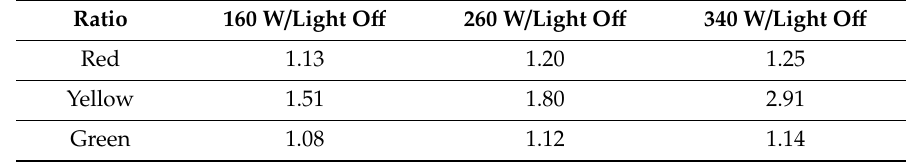
Table 3. Integral value ratio relative to light-o ff condition for red, yellow, and green QDs,